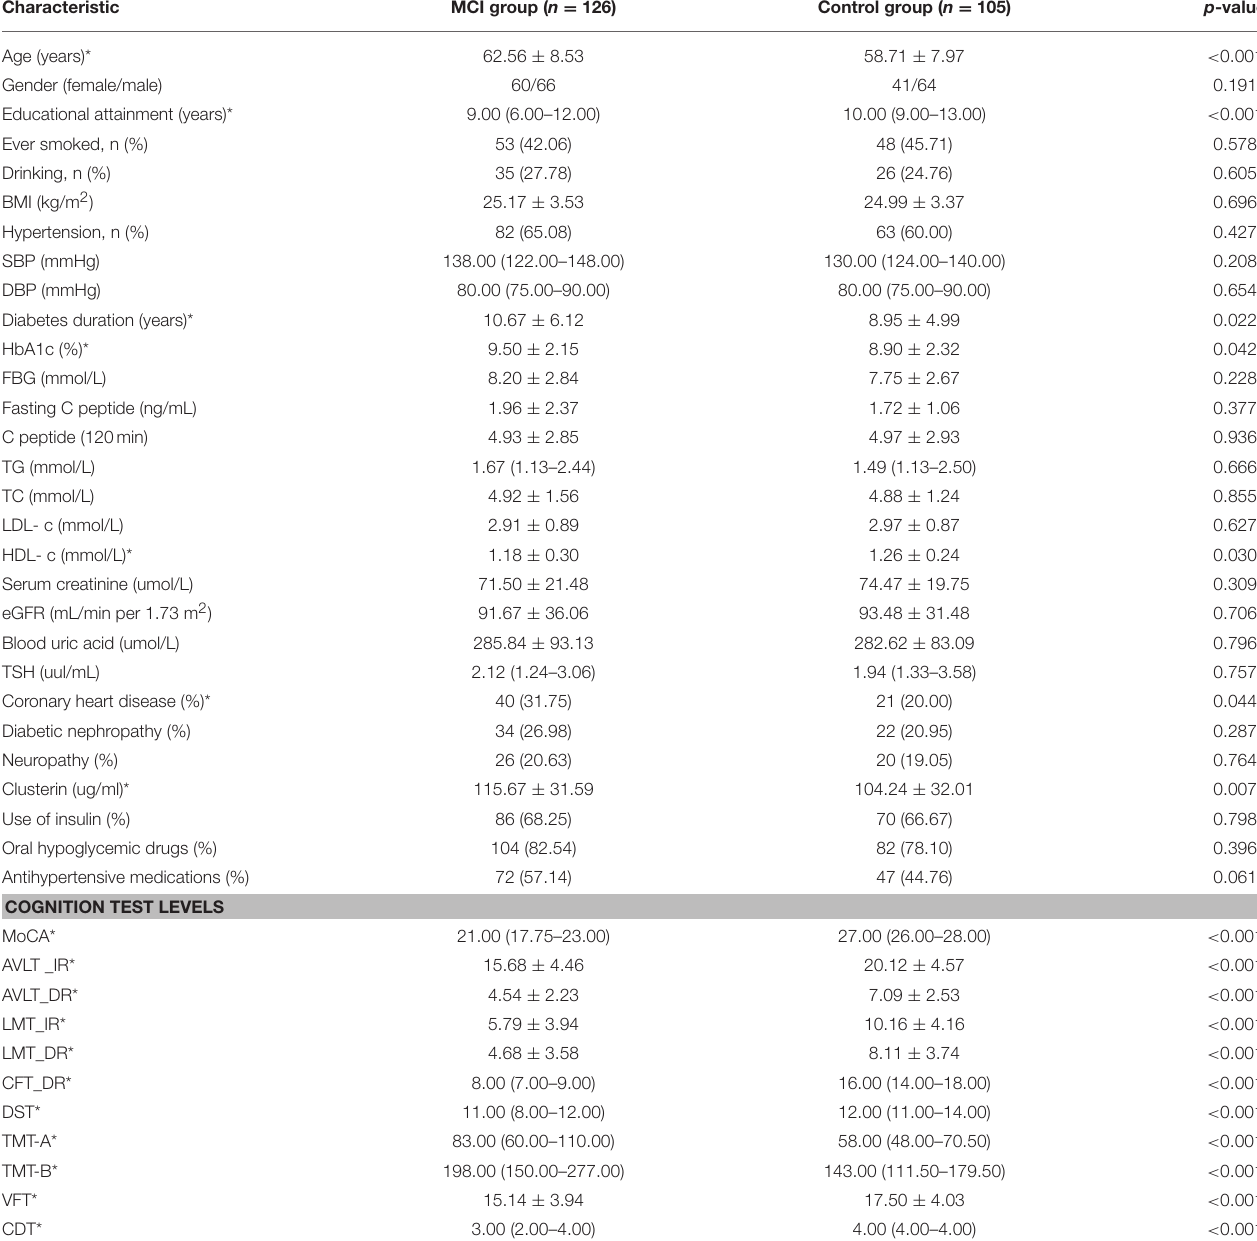
TABLE 1 | Demographic, clinical and cognitive characteristics of type 2 diabetic patients.